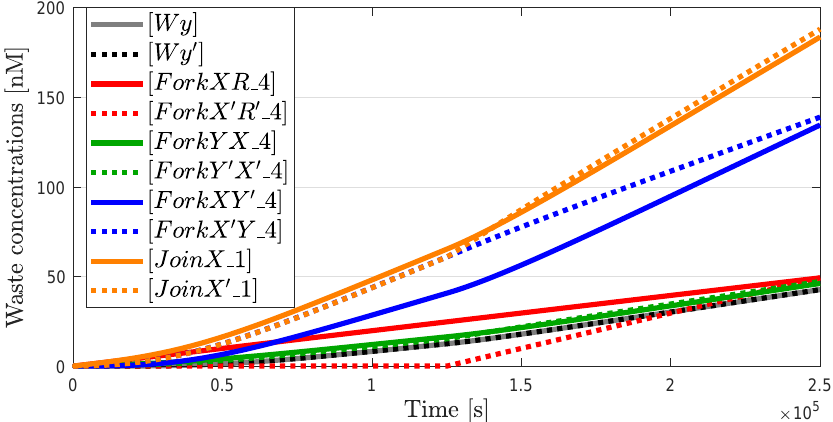
Figure 18. Histories of the concentrations of the waste species from the simulation in Visual DSD of the state feedback control in Example 4: Wy and Wy (cid:48) result from the implementation of Y + + Y − −→ ∅ ; JoinX _1 and JoinX (cid:48) _1 result from implementing X ± −→ ∅ ; ForkXR _4 and ForkX (cid:48) R (cid:48) _4 result from X ± −→ X ± + R ± ; ForkYX _4 and ForkY (cid:48) X (cid:48) _4 result from X ± −→ X ± + Y ± ; ForkXY (cid:48) _4 and ForkX (cid:48) Y _4 result from Y ± −→ Y ± + X ∓